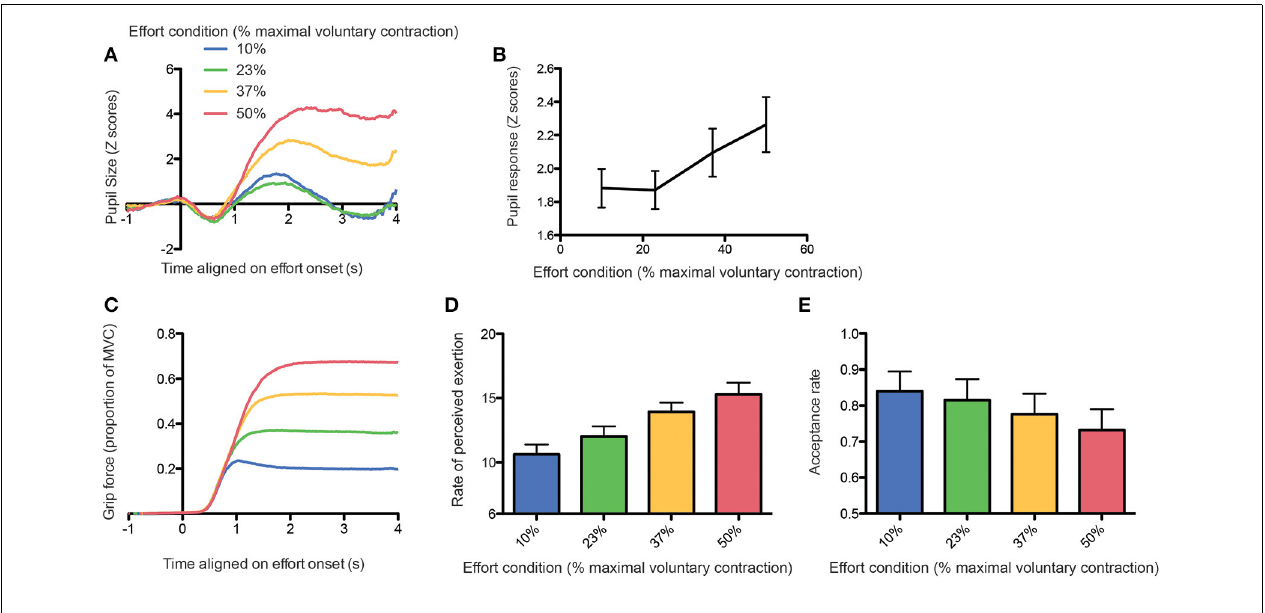
FIGURE 3 | (A) Average pupil size response aligned on effort onset as a function of the effort condition. (B) Peak-to-peak amplitude of the pupil response as a function of the effort condition. (C) Grip force aligned on effort